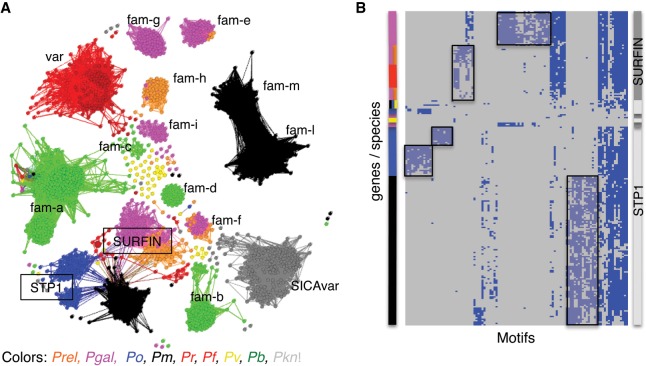
Similarity of gene families within Plasmodium. (A) A network of BLASTP similarity between genes (nodes) sharing at least 31% global identity. Genes are colored by species. The pir genes were excluded due to their large numbers across the Plasmodium genus. Fam-m and Fam-l are P. malariae-specific gene families (Rutledge et al. 2017). (B) Clustering of STP1 and SURFIN genes based on the occurrence motifs identified using MEME. Where a gene (row) has a specific motif (column), the value is set to 1. The matrix is clustered through a hierarchical clustering algorithm (Ward 1963) to visualize similar patterns of motif-sharing. The x-axis represents motifs that occur in at least 10 genes, and individual genes are displayed on the y-axis (rows). Colored bars on the left identify species; the bar on the right, the gene annotation. Boxed areas indicate possible gene family subtypes.